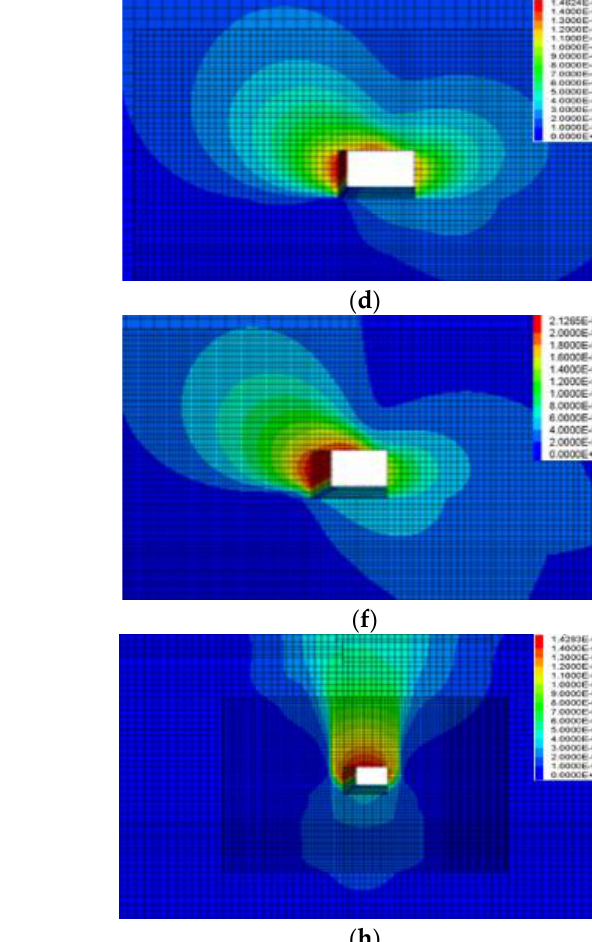
Figure 30. Deformation cloud diagram of the roadway ’s surrounding rock at different locations. ( a ) Roadway excavation along the roof. ( b ) Roadway excavation leaves: top coal bottom coal. ( c ) Roadway excavation along the floor. ( d ) The coal column is 4 m. ( e ) The coal column is 8 m. ( f ) The coal column is 15 m. ( g ) The coal column is 25 m. ( h ) Roadway dug directly below the residual coal pillar.